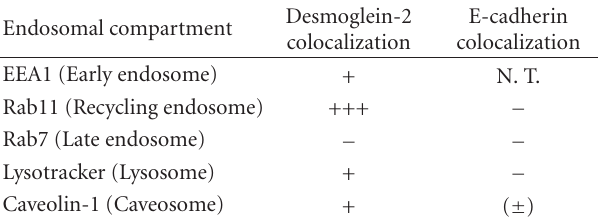
Figure 5: Cadherins do not cointernalize with the EGF receptor. SCC 12F cells were treated with 20nM EGF for 30 minutes, fixed, and probed for EGF receptor (green) or junctional cadherin (red). White arrows indicate the internalized EGF receptor in the cytoplasm while both junctional cadherins, desmoglein-2 (upper panel), and E-cadherin (lower panel) remain at the cell surface 30 minutes post EGF treatment. Table 1: Localization of cadherins with endocytic tra ffi cking mark- ers. Colocalization experiments were conducted using immunoflu- orescence techniques and confocal microscopy as described in “Methods”. EGF treatment ranged from 2–12 hours, and experi- ments were repeated a minimum of 3 times. ( − ) indicates no colo- calization at any timepoint; ( ± ) indicates colocalization at the plas- ma membrane but not in cytoplasm; (+) indicates vesicular colocal- ization in at least one timepoint; (+++) indicates colocalization in vesicles at several